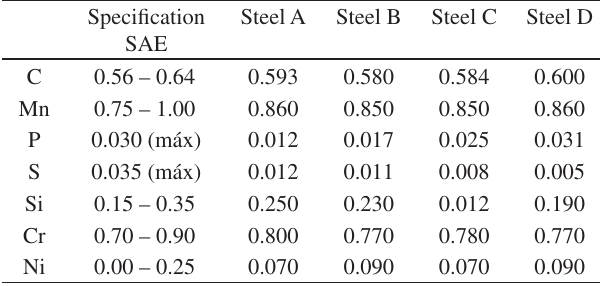
Figure 4. Schematic flowchart of the heating treatment routs for the SAE 5160 steel bars.